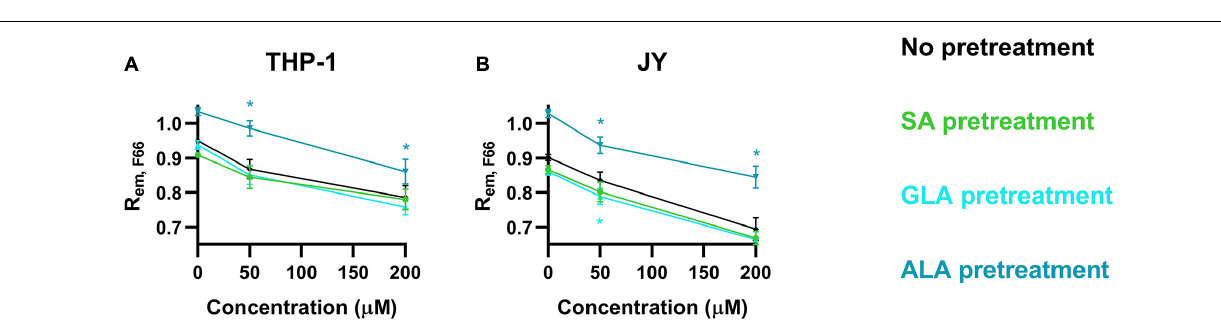
FIGURE 6 | Combined effects of α -linolenic acid (ALA), γ -linolenic acid (GLA) and stearic acid (SA) on the magnitude of dipole potential. THP-1 (A) or JY cells (B) were pretreated with 50 µ M ω -3 ALA, ω -6 GLA or fully saturated SA followed by treatment with 50 or 200 µ M cholesterol, labeling with F66, measurement of the emitted fluorescence intensities of individual cells in the wavelength ranges 470–490 nm and 564–606 nm and calculation of the mean intensity ratio (R em , F 66 ) from data of at least 20,000 living cells per sample. The average values of five independent measurements ( ± SD) were plotted as a function of the applied concentrations of cholesterol after pretreatment with ALA (blue), GLA (cyan) and SA (green). Asterisks (*) indicate significant differences compared to samples without pretreatment ( p < 0.05, ANOVA followed by Tukey’s HSD